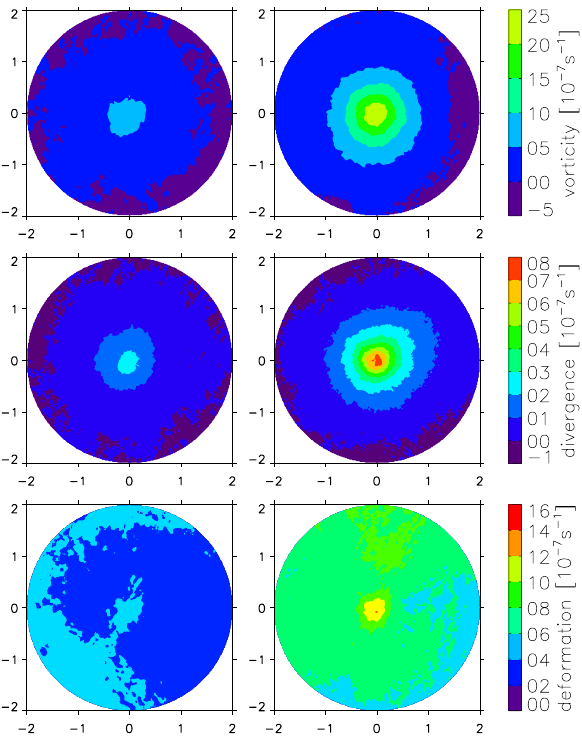
Fig. 7. Composite fields of vorticity (top), divergence (middle), and deformation (bottom) for intensity classes I 1 (left) and I 4 (right).